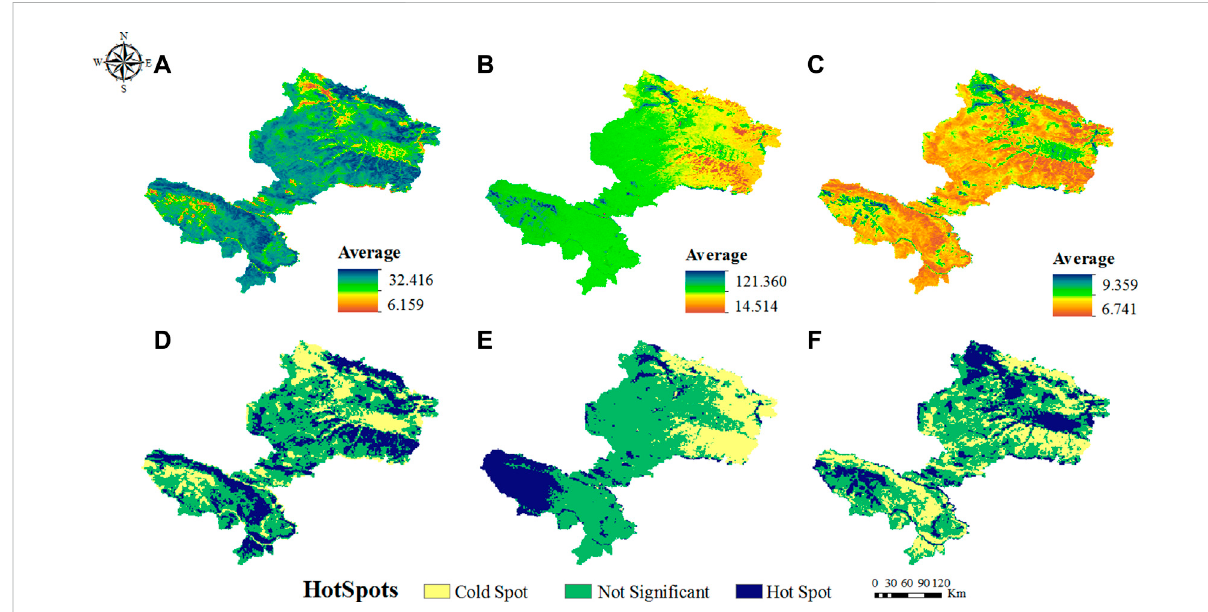
FIGURE 6 Spatialpatternsofmeanmulti-annualandGetis-OrdGi*: (A) meanmulti-annualofSWC, (B) meanmulti-annualofEC, (C) meanmulti-annualof pH, (D) hot spot of SWC, (E) hot spot of EC, and (F) hot spot of